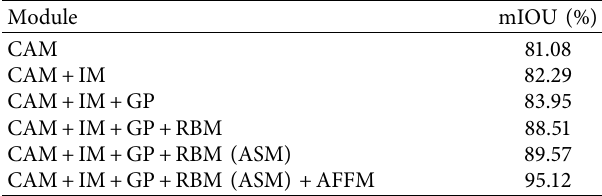
Table 3: Detailed performance comparison of each component in our proposed ED-Net.